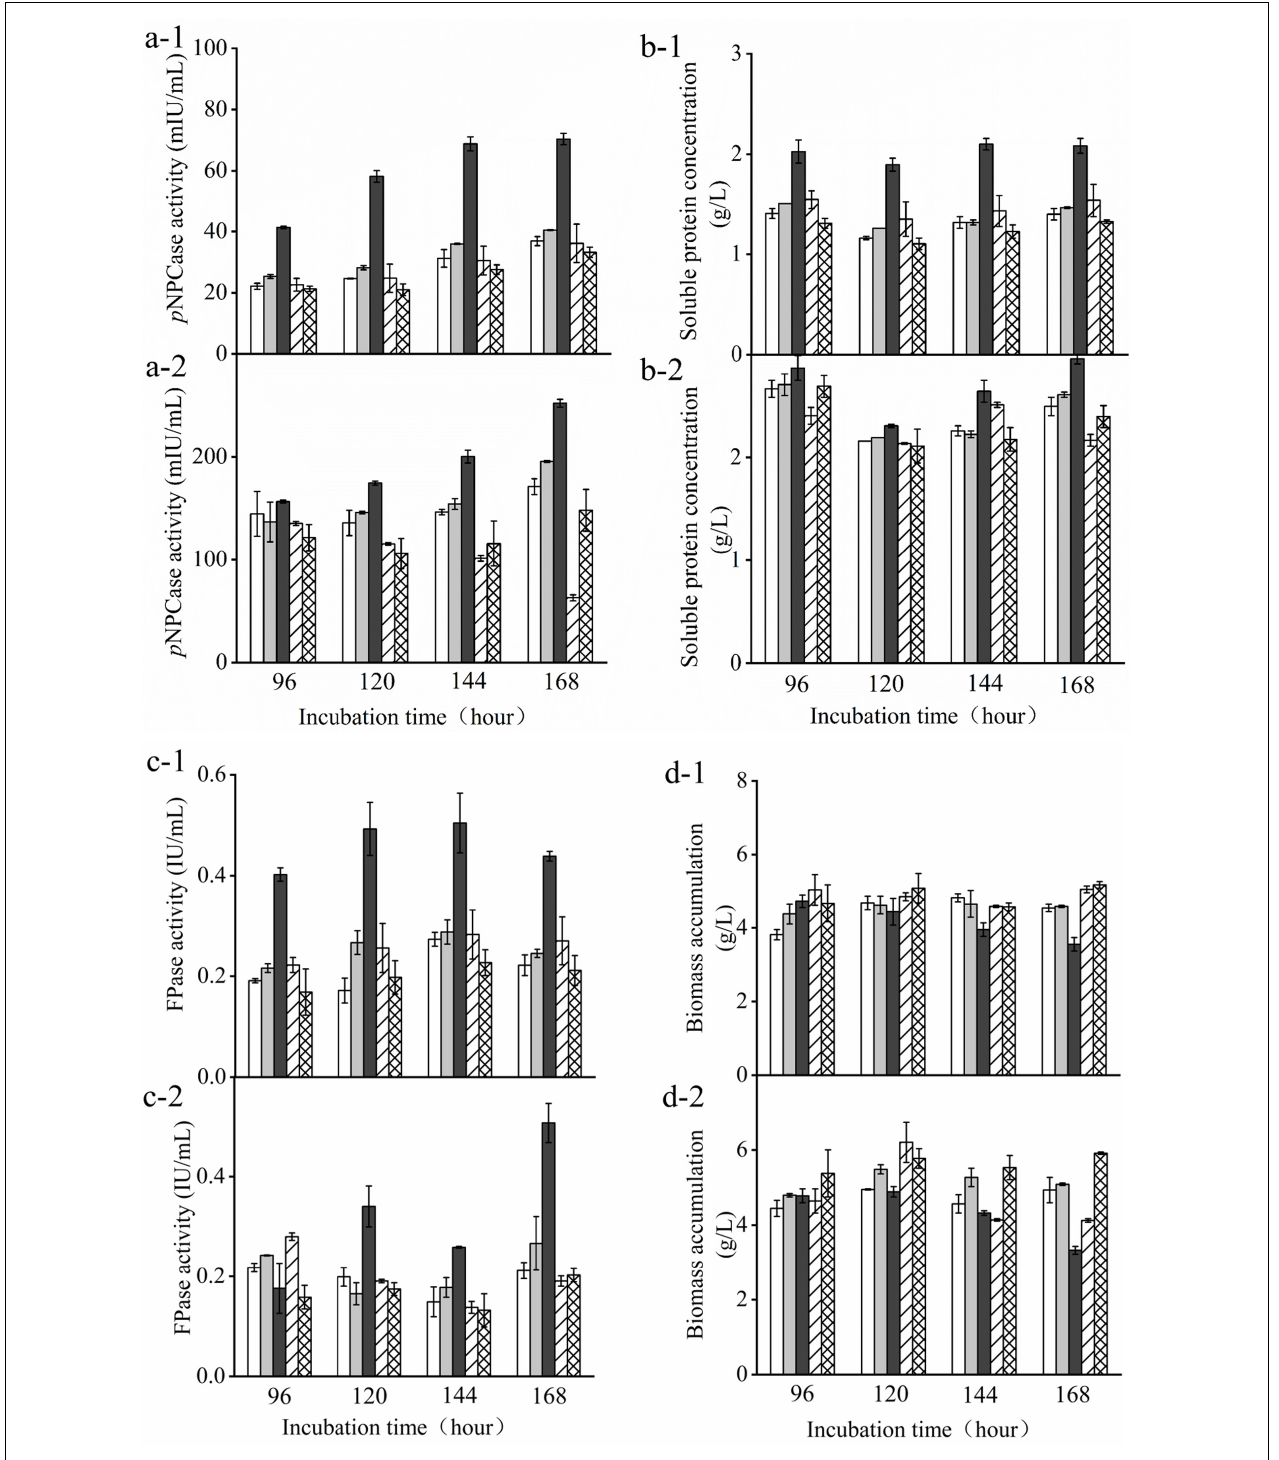
FIGURE 3 | Determination of cellulase activity in the presence of glucose. T. reesei transformants and the parent strain were cultivated in liquid medium supplemented with 2% (w/v) (x-1) glucose or (x-2) a mixture of glucose and avicel as carbon source. Activity of p -nitrophenyl- β − D -cellobioside ( p NPCase) (a) , soluble protein (b) , filter paperase (FPase) activity (c) , and biomass accumulation (d) of each culture were measured in biological and technical duplicates. Enzymatic activities are given as mean values, with error bars indicating the standard deviation. Symbols: blank, parent strain; light gray, Tr _Cre1 S387V ; dark gray, Tr _ Cre1 S388V ; oblique line, Tr _ Cre1 T389V ; gridline, Tr _ Cre1 T390V .